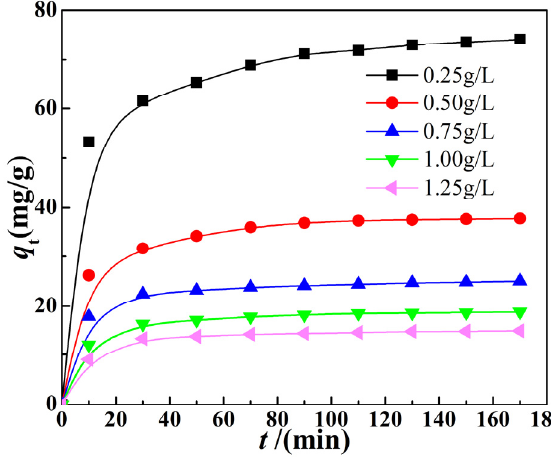
Figure 3 Effect of adsorbent dosage on the adsorption.